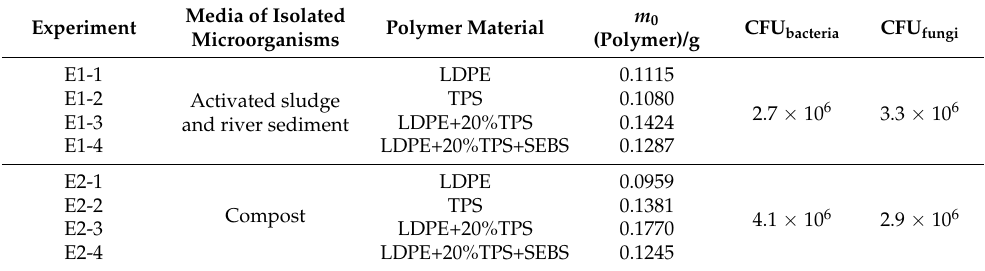
Table 1. The initial working